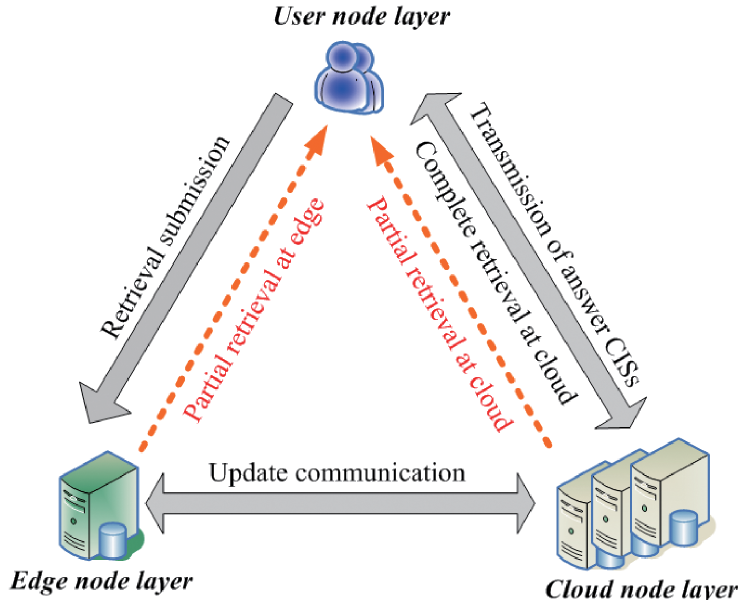
Fig 2. The three layer architecture of the BRS